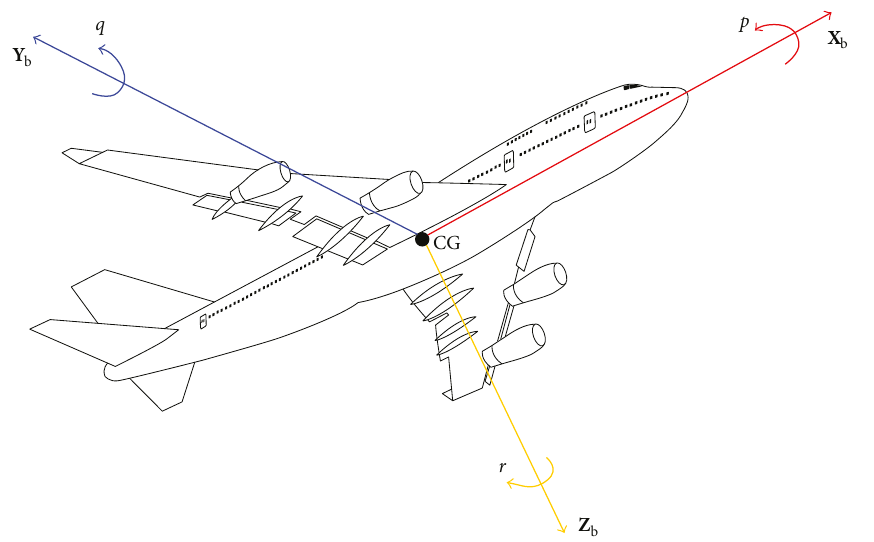
Figure 2: The roll, pitch, and yaw delta angles p , q , and r